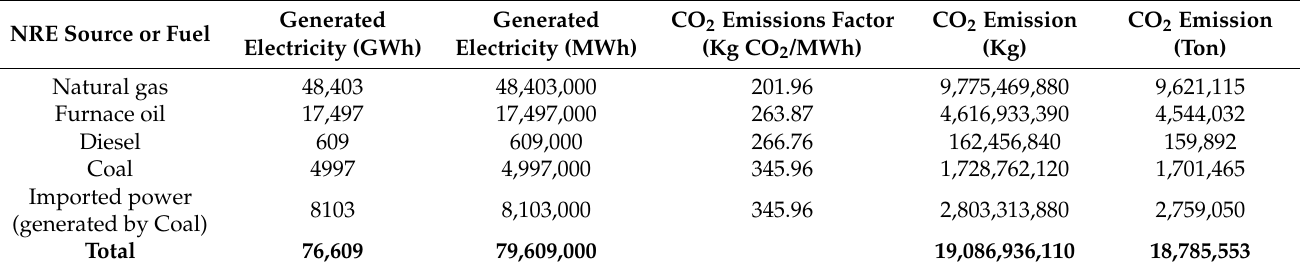
Table 10. CO 2 emission from electricity generation by nonrenewable energy sources of Bangladesh in FY 2020–21 (authors’ creation based on